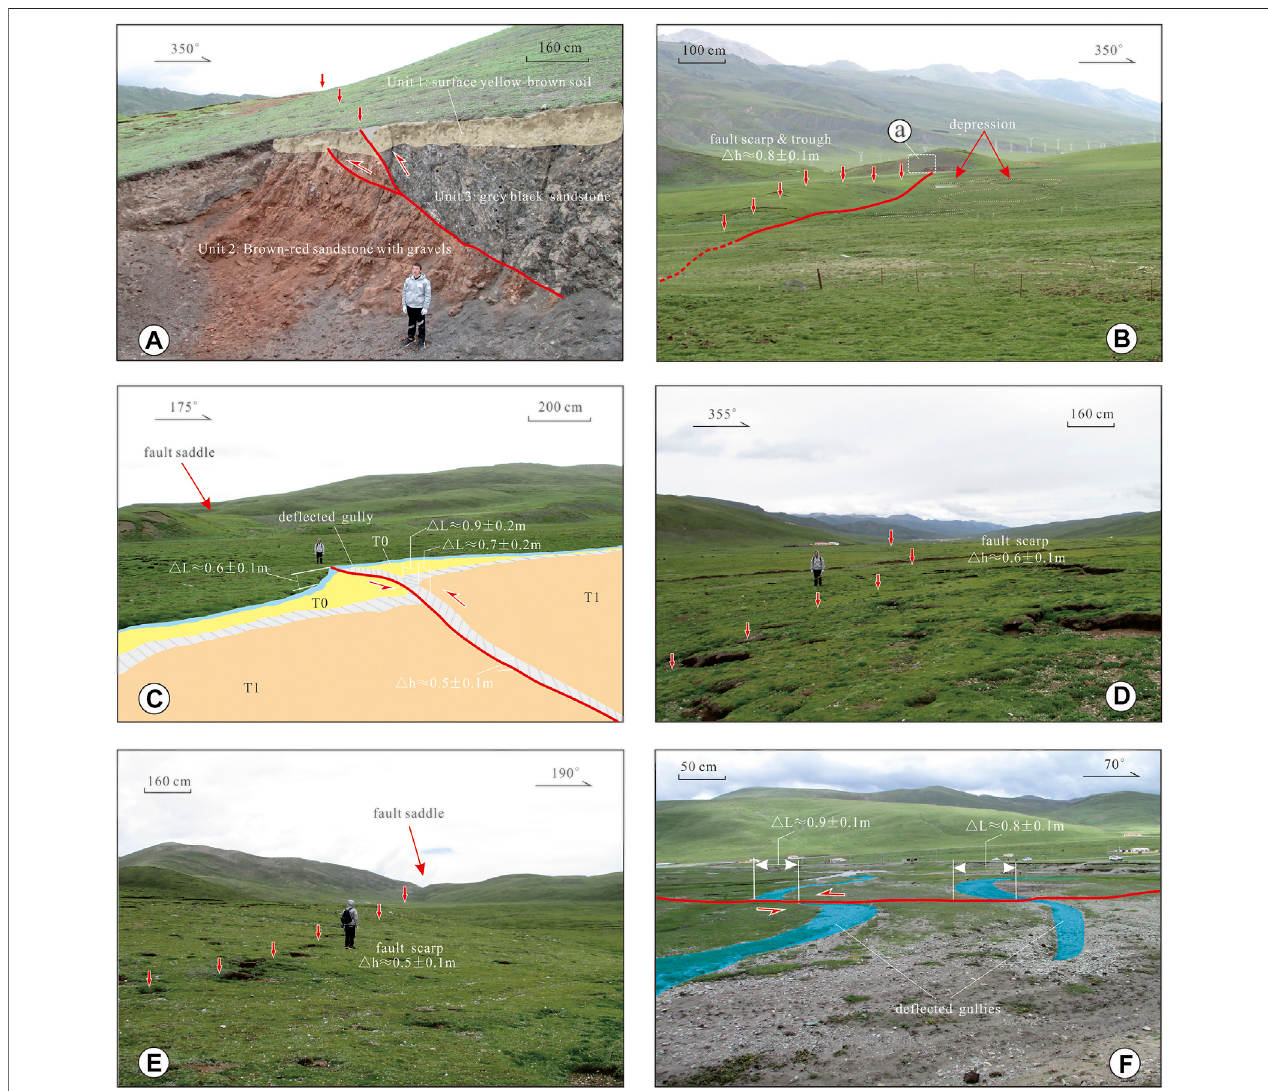
FIGURE 9 | Photographs of representative tectonic landforms of the DJF and CE 1738 co-seismic surface ruptures in the eastern section. Red arrows represent the distribution of co-seismic tectonic characteristics such as fault scarps, mole tracks, and depressions. The azimuth angles in the photographs represent the section direction. Note the difference in each scale. Pictures from, to correspond to the locations of the photographs in Figure 3 E. (A) Paleogene brown – red sandstone with gravelsinfaultcontactwithTriassicgrayblacksandstone,andthelatestactivityofthefaulthasrupturedthesurfacemodernyellow – brownsoilinathrustway.Note the person in the map for scale; (B) fault scarp, trough and depressions developed within unconsolidated alluvial and pluvial sediments, which are duplicated in a preexistingstructurezone.Notethattheheightofthescarpis~0.8±0.1 m; (C) agullywasde fl ected(by0.7±0.2 m)byco-seismicsurfaceruptureswhereafaultscarp wasobserved with aheight of ~0.5 ± 0.1 m on average; (D,E) fault scarp developed within unconsolidated alluvial deposits, and the scarp height is ~0.5 ± 0.1 m. Fresh mole tracks can be observed in the same direction as the fault zone; (F) two modern gullies were de fl ected with average horizontal displacements of ~0.8 ± 0.1 m.